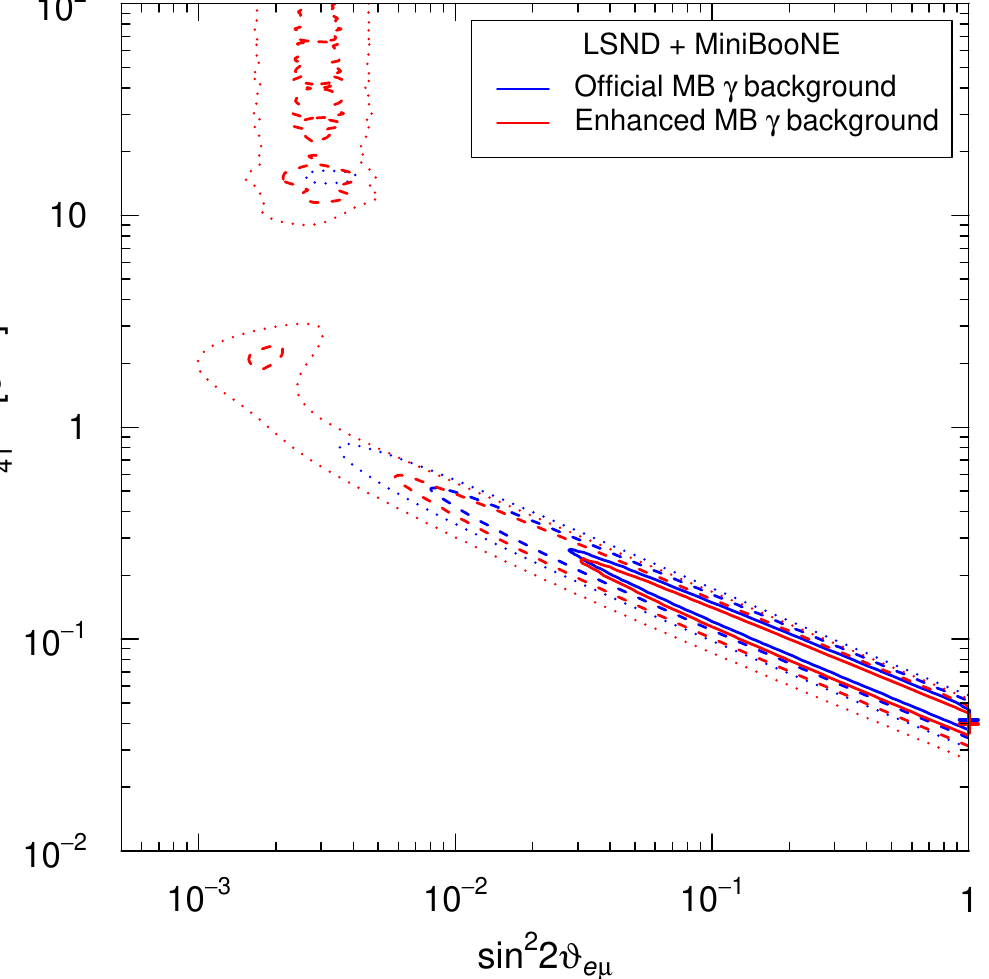
and sin 2 2 ϑ (bf) eµ are the 41